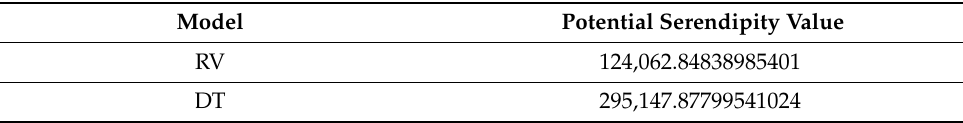
Figure 10. The information taxonomy (totally 5 domain pages with 75 content pages). Table 3. Potential serendipity value of